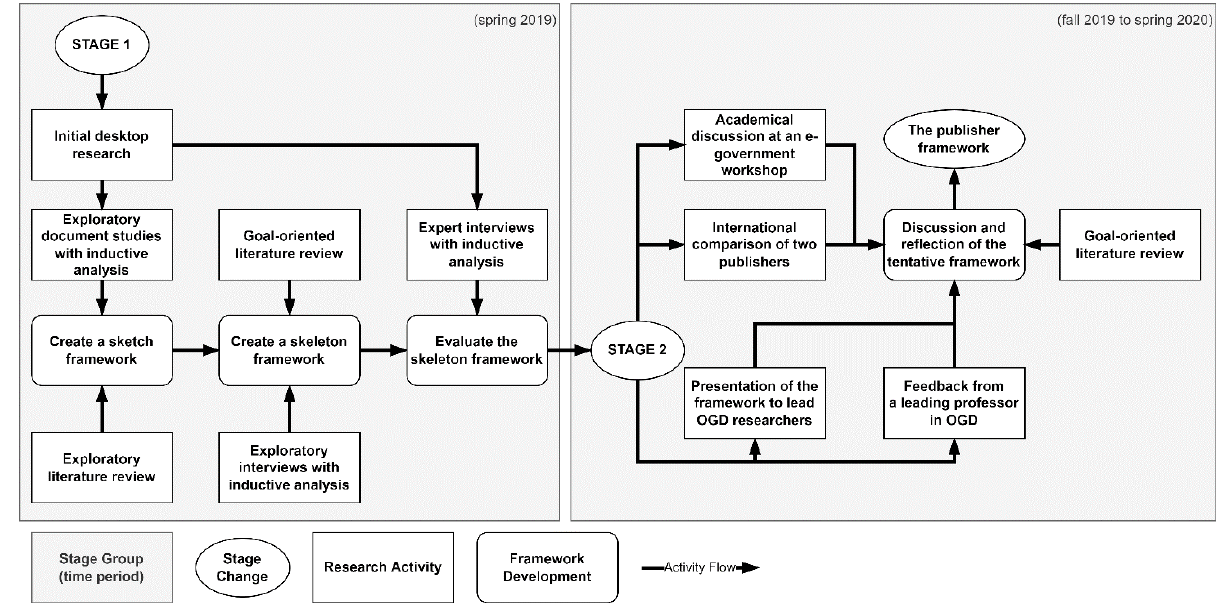
Figure 1: Detailed view of the research